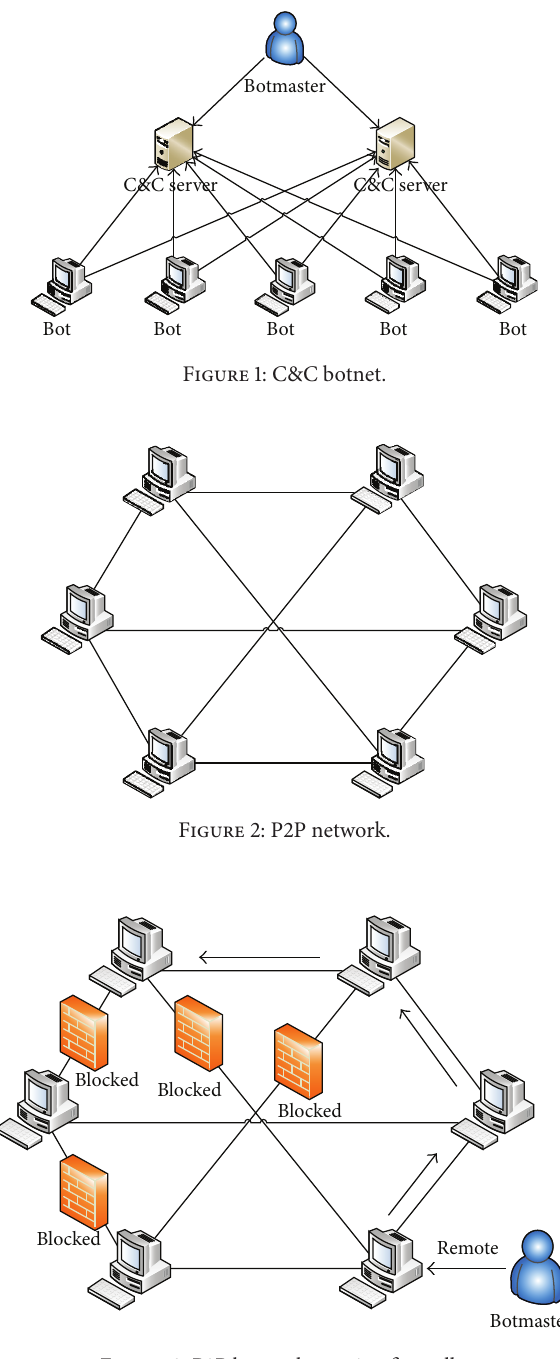
Figure 3: P2P botnet bypassing